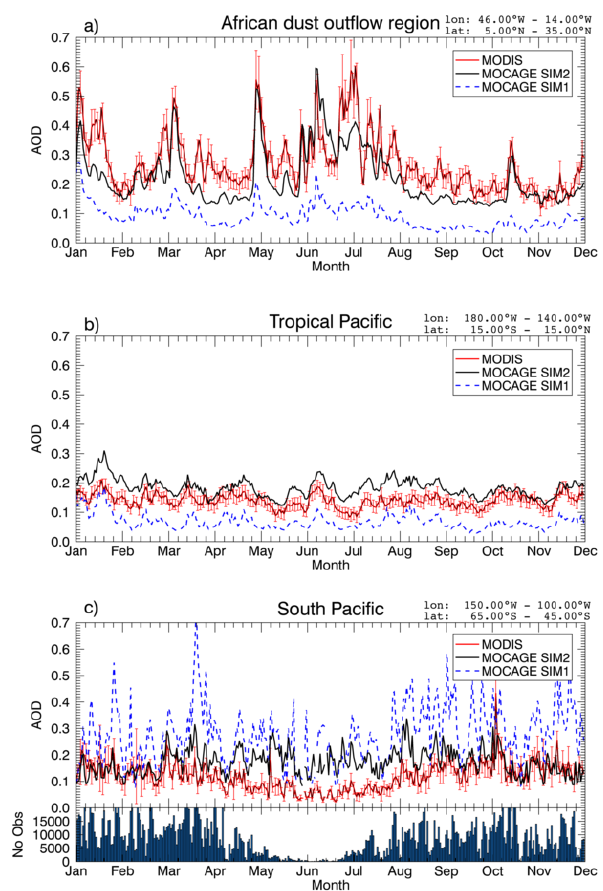
Figure 6. Time series of aerosol optical depth at 550nm in 2007 of MODIS (Aqua + Terra) data, SIM1 and SIM2 over (a) the African desert dust outflow region (45–15 ◦ W, 5–35 ◦ N), (b) the tropical Pa- cific (180–140 ◦ W, 15 ◦ S–15 ◦ N), and (c) the South Pacific (150– 100 ◦ W, 65–45 ◦ S). The regions are also marked in Fig. 4a. For the South Pacific region, the number of observations over the region is given for each day. Correlation, modified normalized mean bias and fractional gross error for both SIM1 and SIM2 as compared to MODIS data are given in Table 3. The descriptions of model simu- lations are in Table